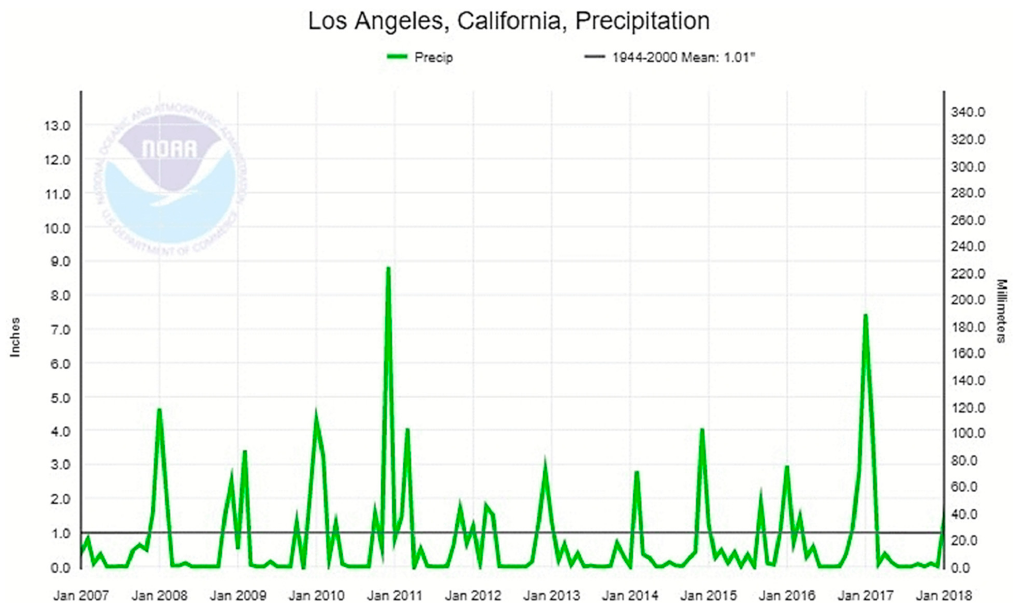
Figure 4. Precipitation time series for Los Angeles, California between January 2007 and January 2018 [95]. Table 3. Descriptive history of the Portuguese Bend landslide complex (2007–2017).